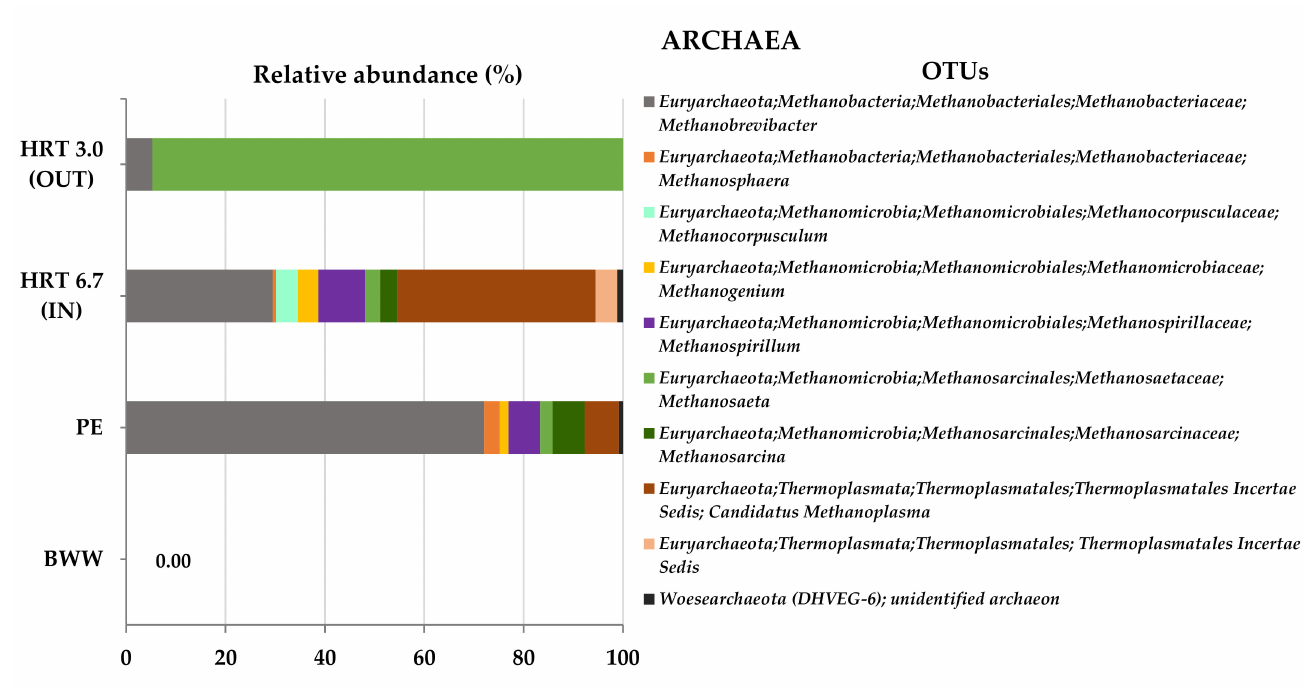
Figure 7. Relative abundance and dynamics of archaeal communities and taxonomic classification of archaeal reads at genus level in samples collected at two operating conditions and effluents. BWW—Brewery wastewater, PE—Piggery effluent, HRT—Hydraulic retention time, OUT—Operational taxonomical